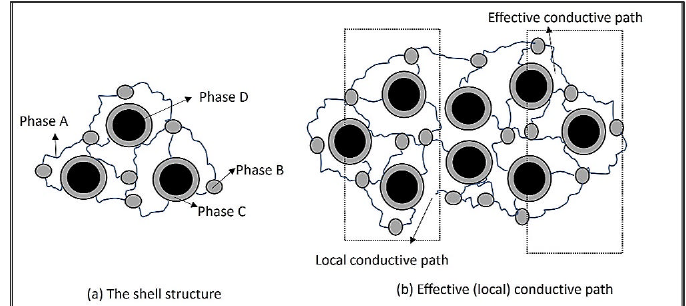
Figure 1. The schematic diagram for the shell structure where phase A is a rubber molecule chain, phase B is the crosslinking between the rubber chains, phase C is a macro-rubber that is absorbed by the carbon black surface, and phase D is the carbon black nanoparticle. ( a ) The effective (local) conductive path ( b ) of a nanocomposite [32].